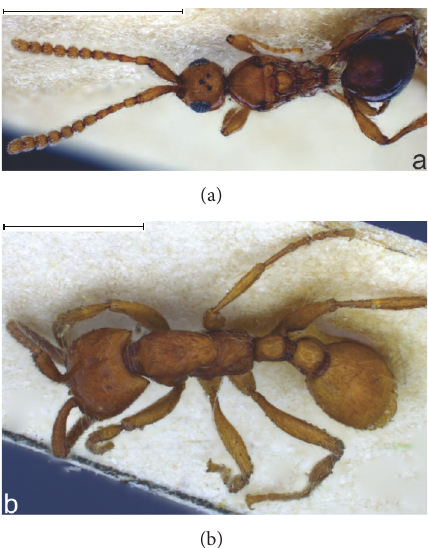
Figure 1: (a) Asolenopsia rufa female dealate in dorsal view. (b) Neivamyrmex carettei. Scale: 1 mm.